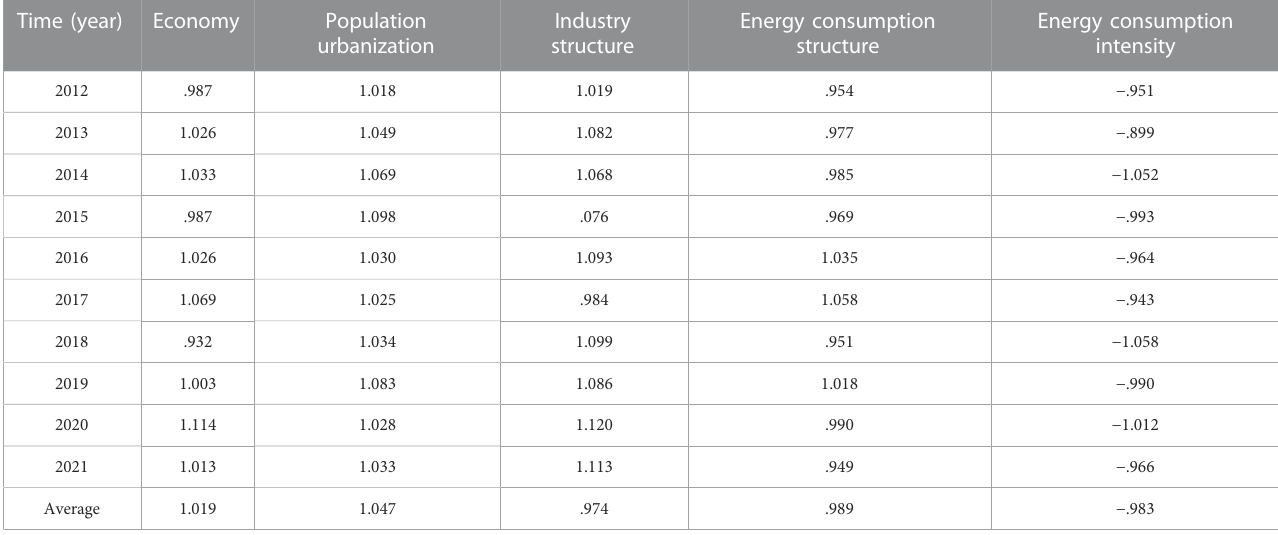
TABLE 5 GFI decomposition results of carbon emission in fl uencing factors from 2012 to 2021. Time (year)